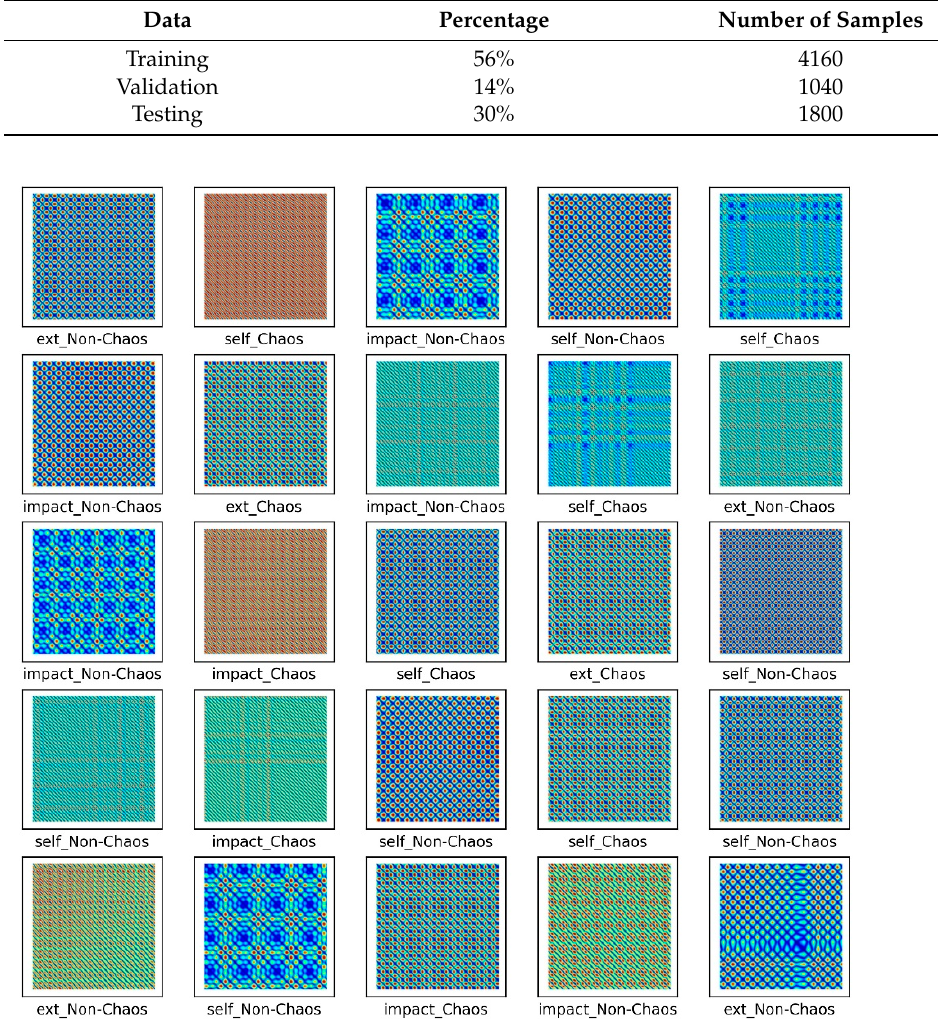
Figure 15. Unthresholded RP for the S&R model.